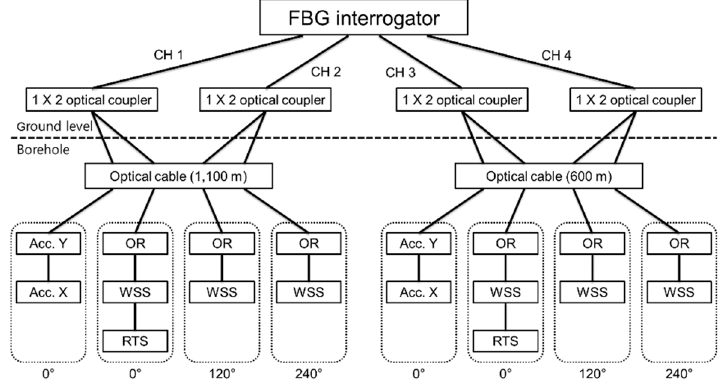
Figure 14. Connection method of the FBG interrogator, FBG sensor, and optical fiber cable at the TEBD observatory.